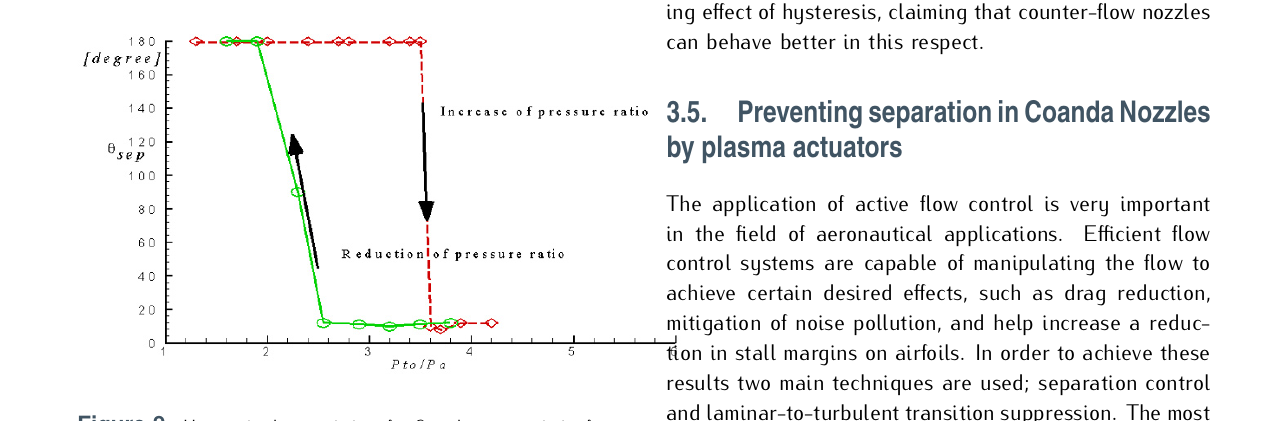
Figure 9. Hysteretic characteristics of a Coanda supersonic jet for a ratio of R/t = 5. Data compiled from